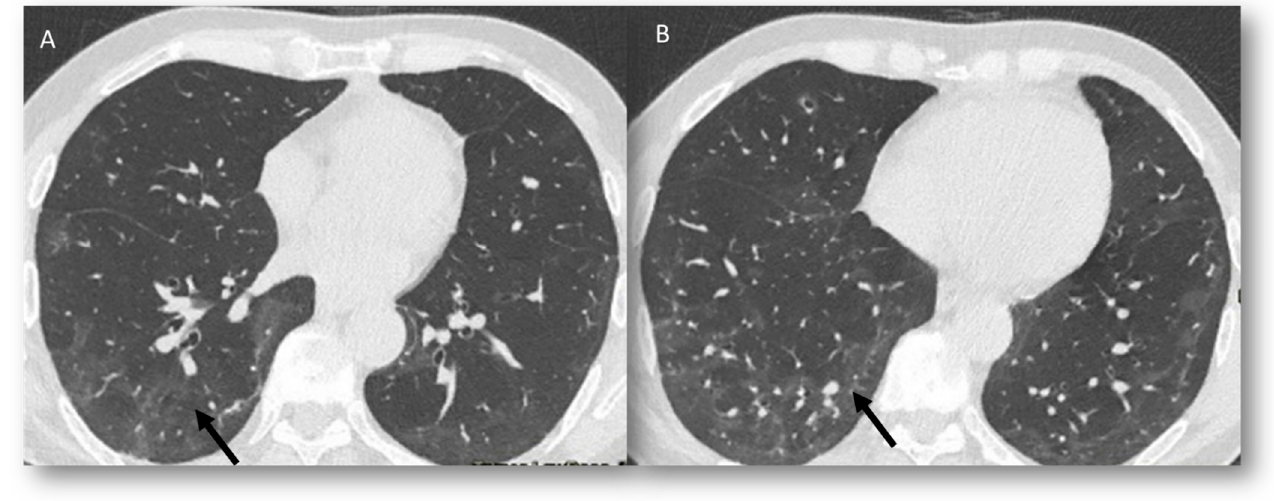
Figure 7. CT assessment of COVID-19 pneumonia ( A , B ): multifocal and bilateral distribution of ground-glass opacities (arrows). ground-glass opacities (arrows).